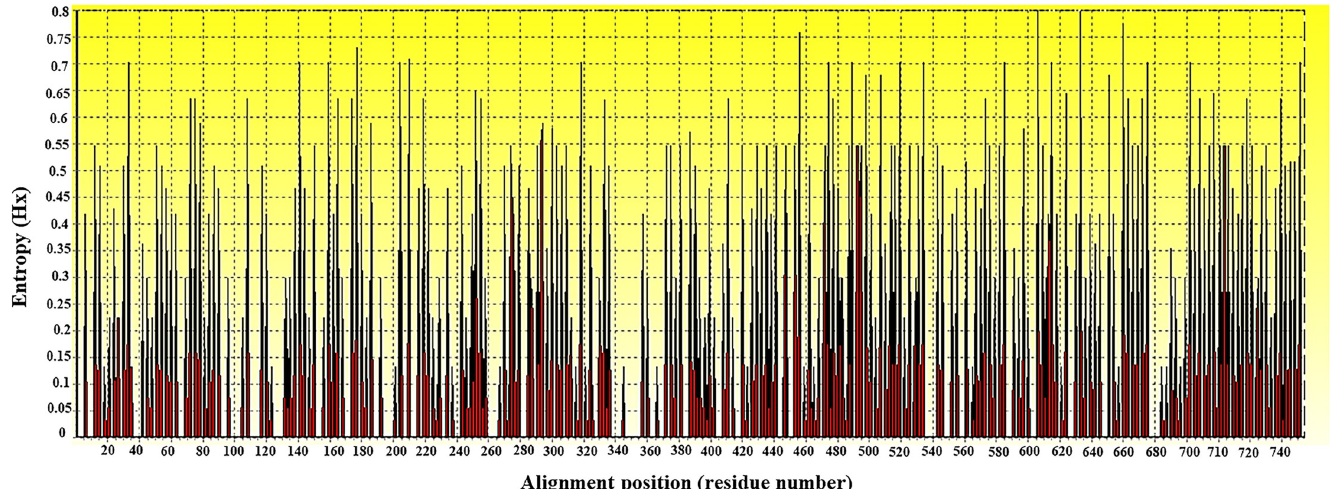
Fig 2. Entropy plot of partial dnaK nucleotide sequences of Coxiella sp. Entropy plot of multiple nucleotide sequence alignment of dnaK -encoding genes. The dark peaks indicate the high variation at each position of the nucleotide sequences.